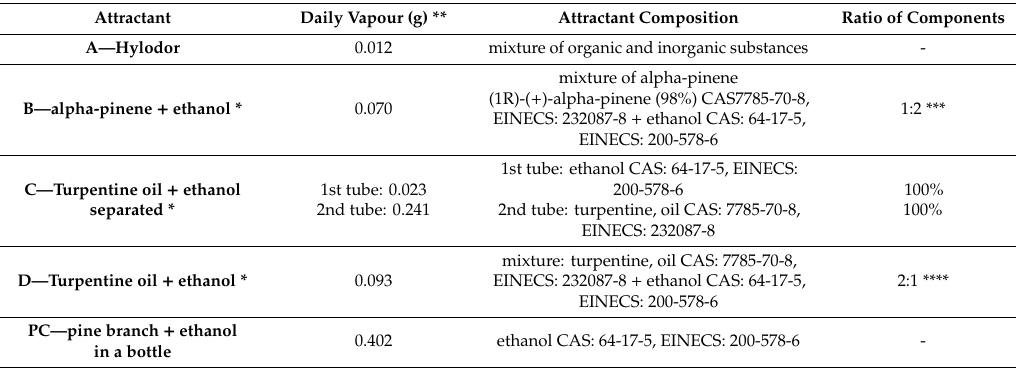
(Table 2). The polypropylene tubes were used for the other three kinds of attractants and the control. After the tubes were filled, they were head sealed, and the content was released only through the polypropylene walls. Table 2. Descriptions of the attractants.